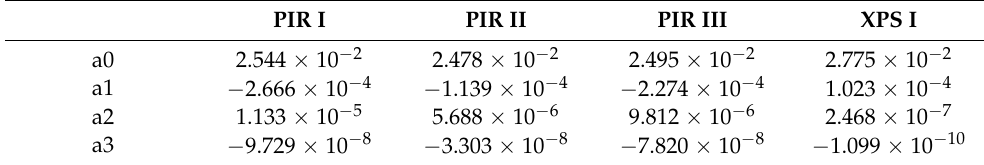
Table 3. Cubic polynomial coefficients for closed-cell foam insulation aged at − 10 ◦ C.